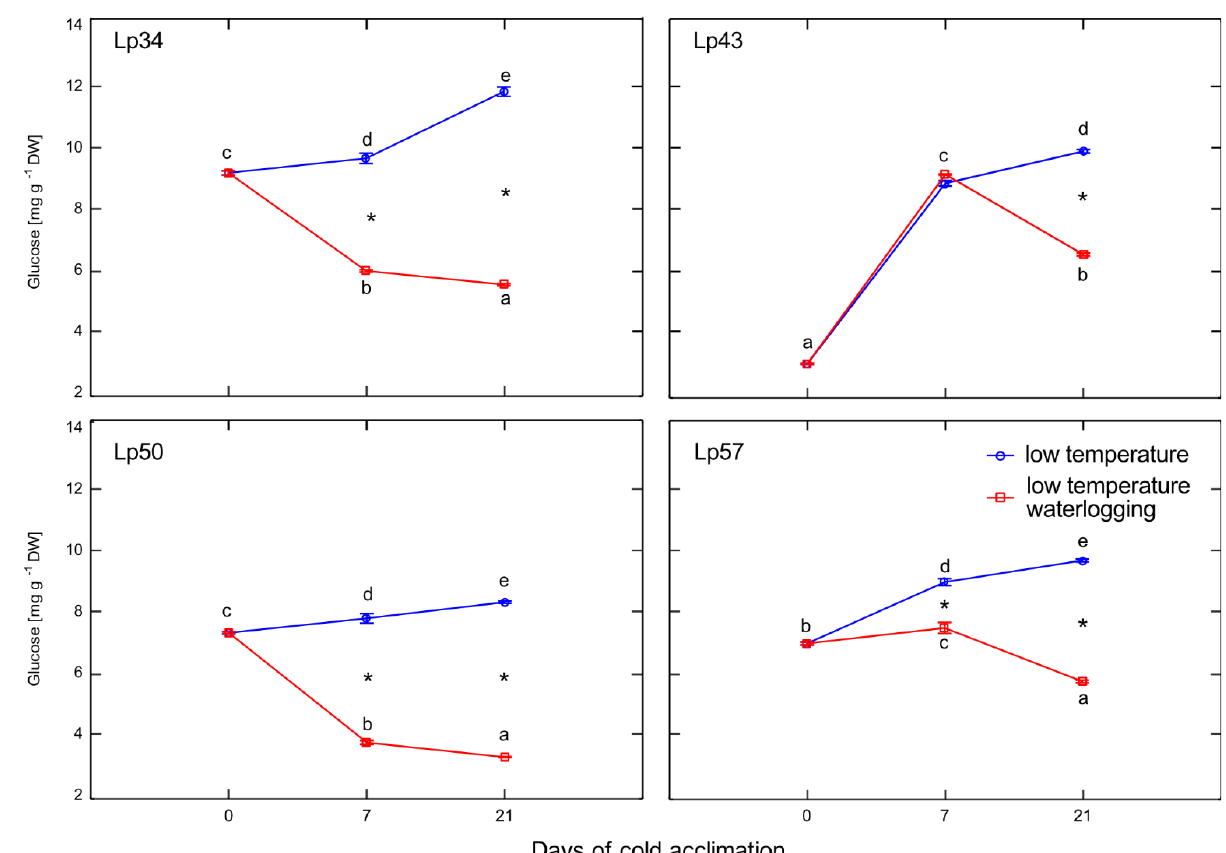
Figure 6. Glucose content of cold-acclimated Lolium perenne genotypes. Four genotypes (Lp34, Lp43, Lp50, and Lp57) were tested. The results are means ( n = 4), error bars indicate the standard error. Asterisks indicate means that differ significantly between waterlogged and control plants according to one-way ANOVA ( p < 0.05). Different lower-case letters indicate means that are statistically different according to Duncan’s multiple range test ( p < 0.05).